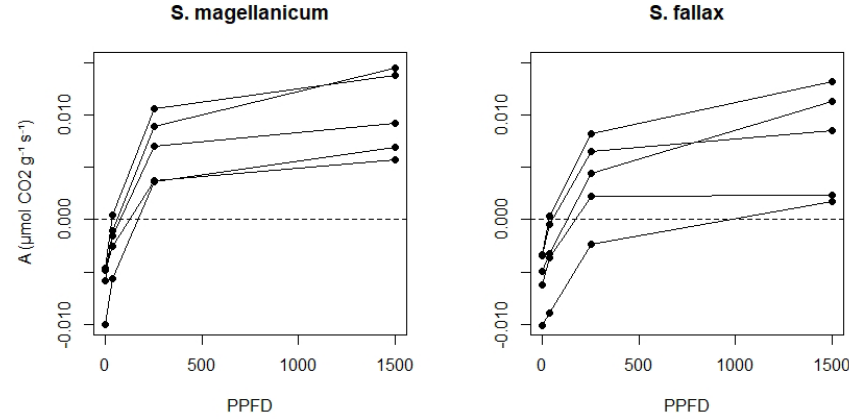
Figure B1. Measured light response curves for S. magellanicum and S. fallax .